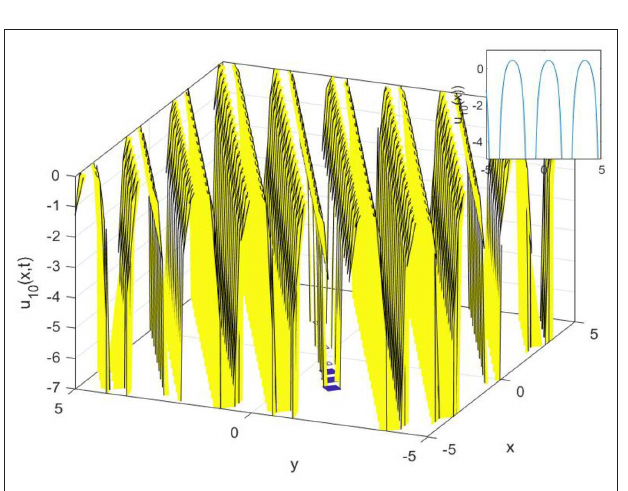
FIGURE 10 | The 3D, 2D, and contour surfaces of Equation (40) using A 1 5, α 4, and ǫ 2. = = =